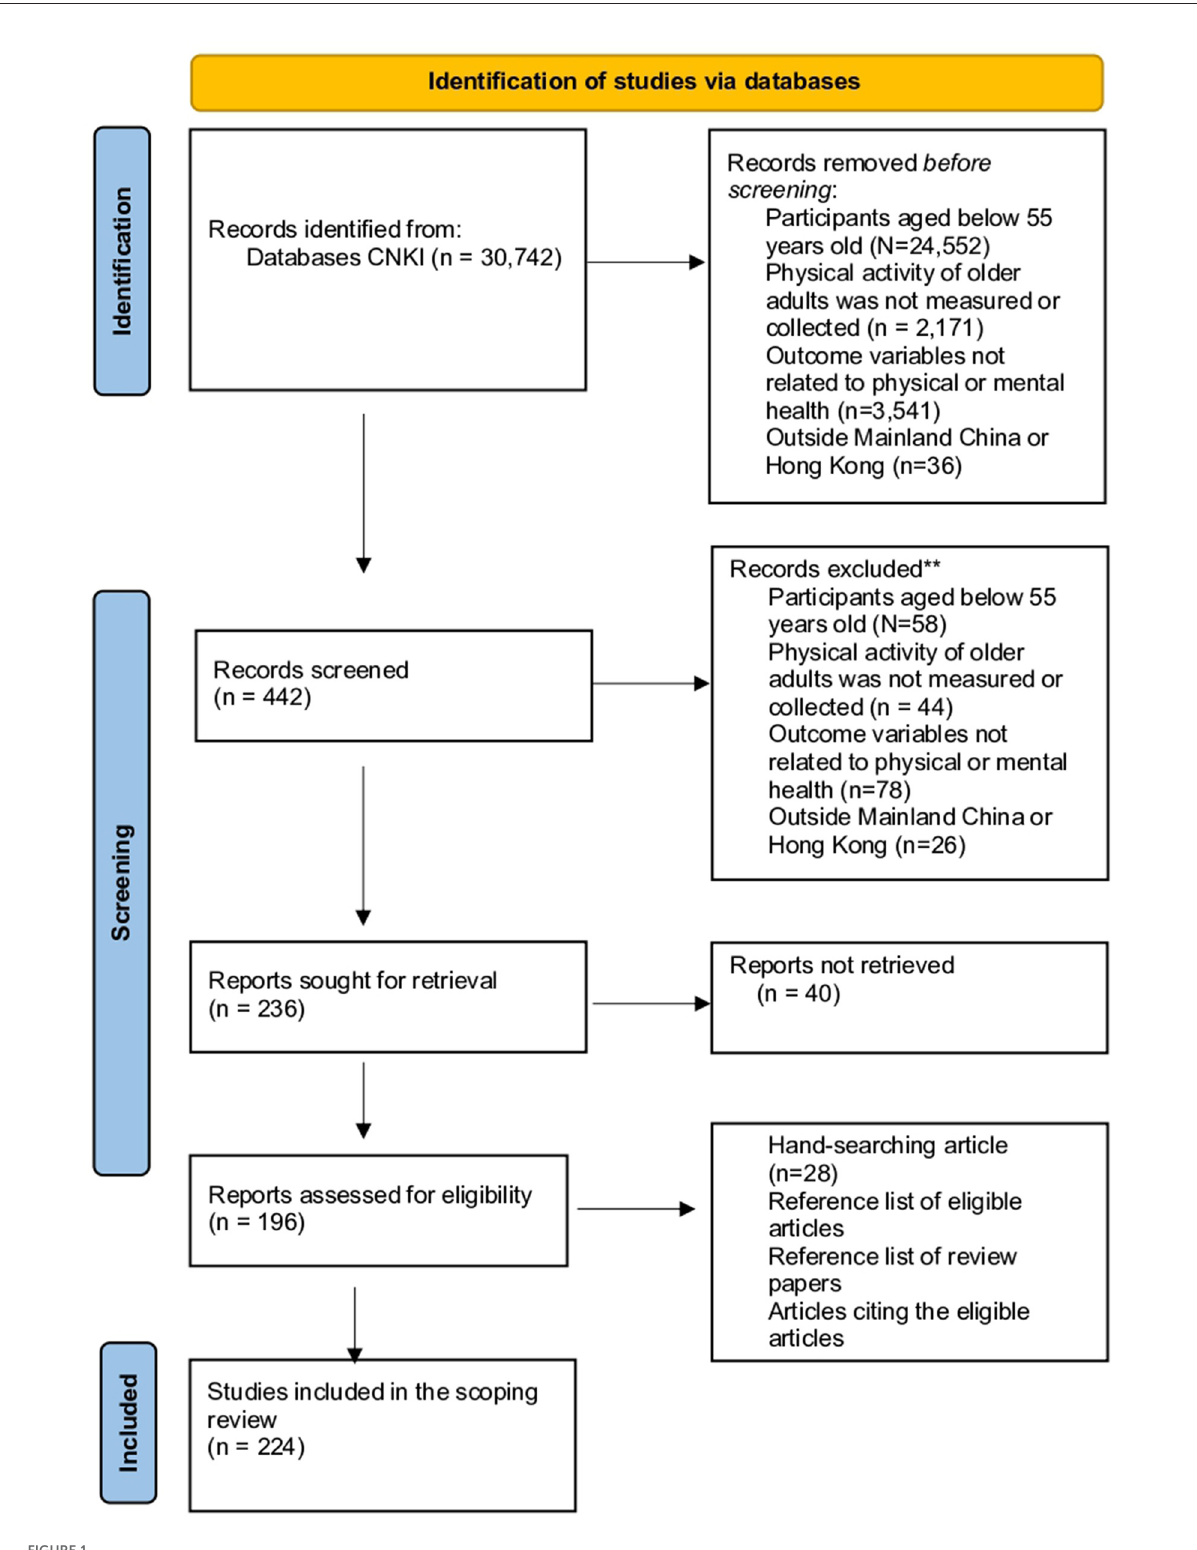
FIGURE1 Chinese article screening